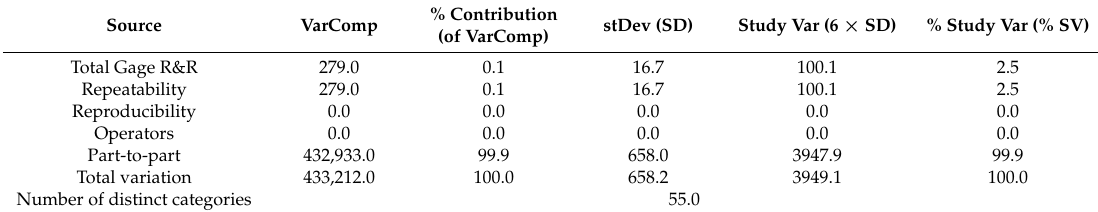
Table 6. Condition 2 Gage R&R for the Q factor.